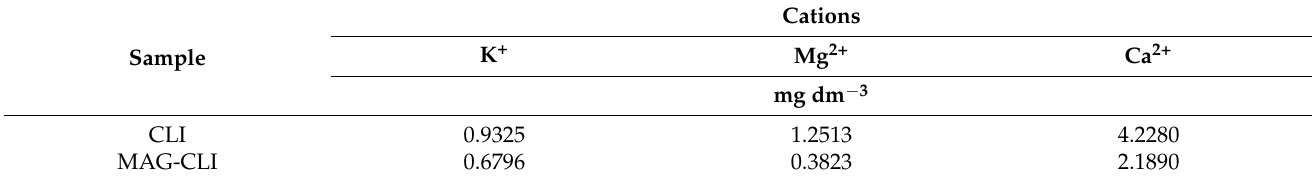
Table 5. The concentration of exchangeable cations in filtrates after the CIP adsorption on CLI and